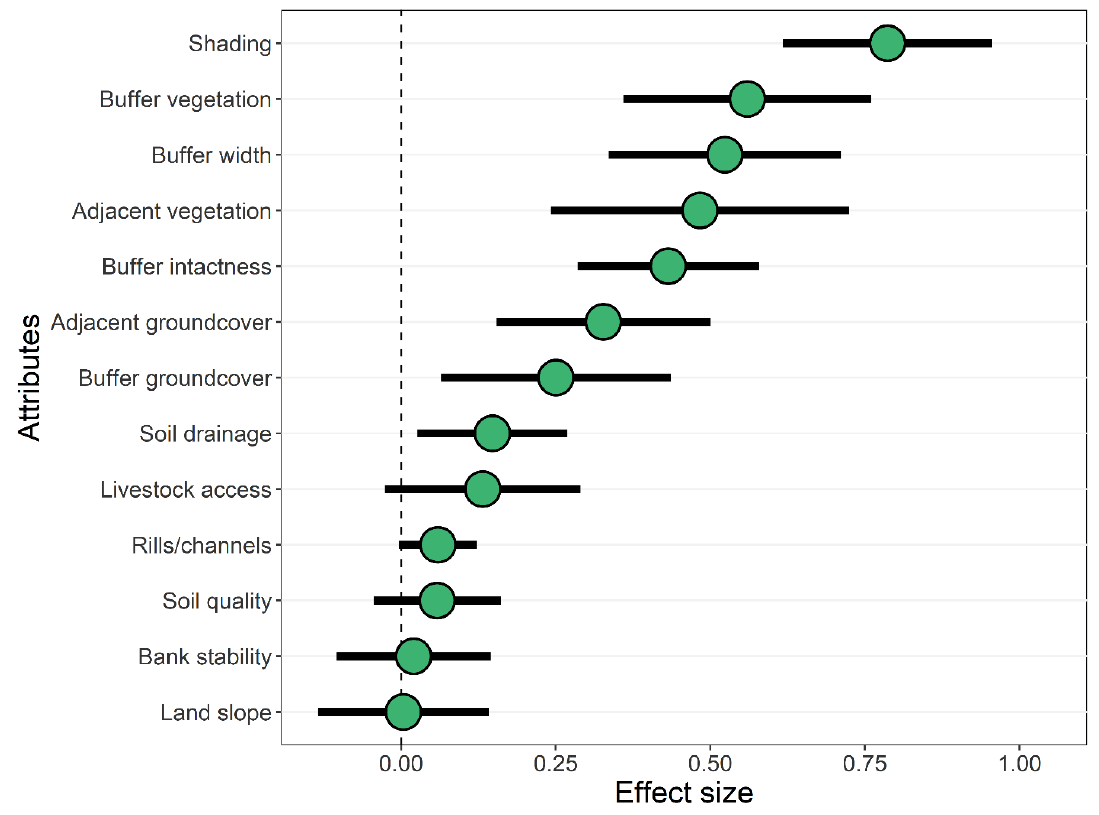
Figure 4. Mean log response ratios (± 95% CI) showing the change between downstream sites buffered with woody riparian vegetation (i.e., forested) and upstream sites without this type of buffer for each attribute used in the Riparian Condition Index. This plot include data from sites in Norway, Sweden, Belgium, and Romania.